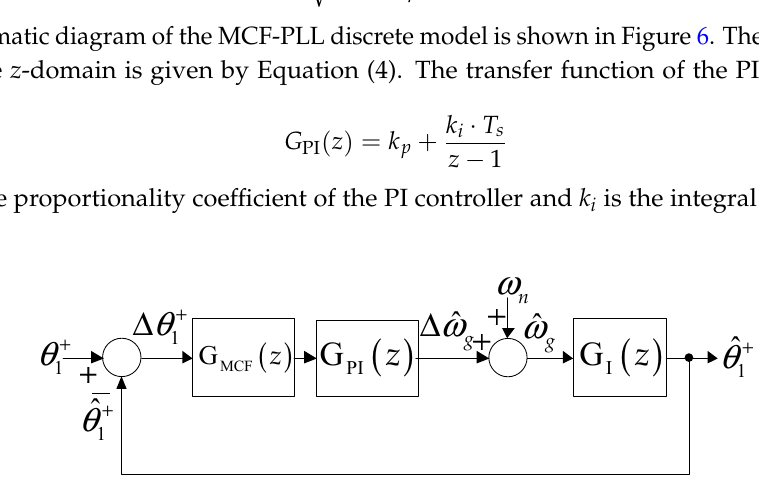
Figure 6. Schematic diagram of MCF-PLL discrete model.